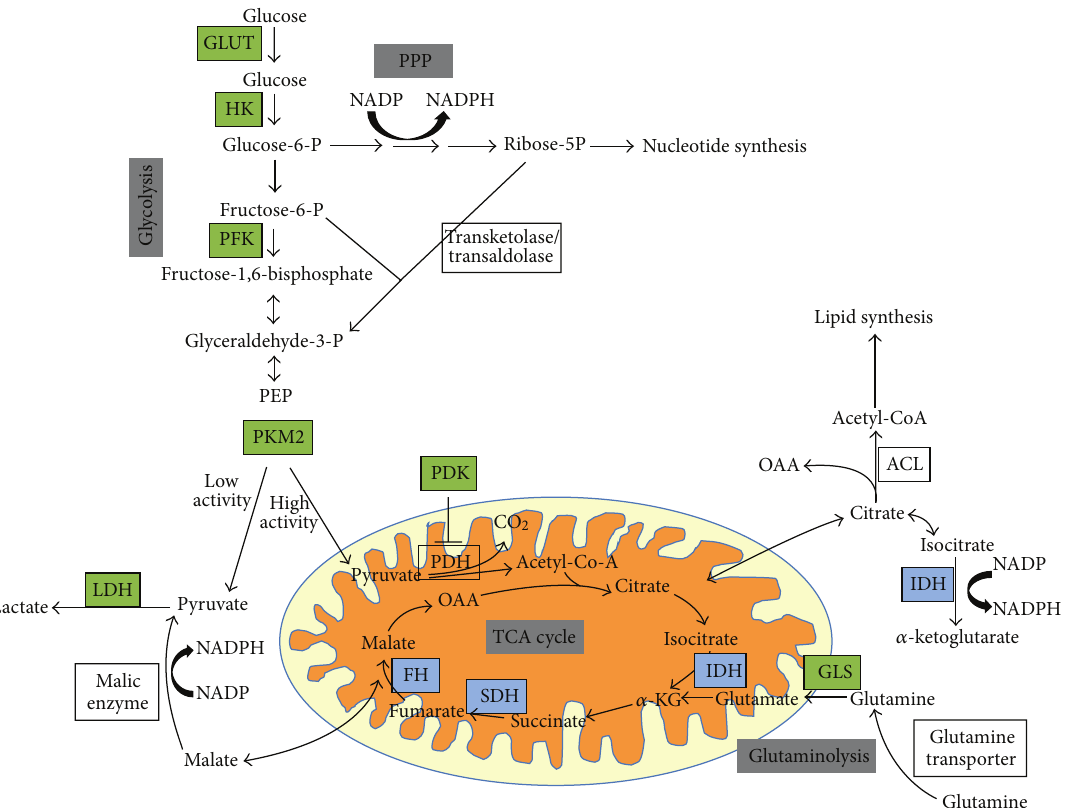
Figure 1: Metabolic adaptations of cancer cells. Glucose and glutamine are the 2 major substrates used by cancer cells. Glucose is imported into the cells through glucose transporters (GLUT) where it is phosphorylated by Hexokinase (HK). It will then be either metabolized through glycolysis or diverted to the pentose phosphate pathway (PPP). Glucose-derived pyruvate is mainly converted into lactate in cancer cells instead of being imported into mitochondria to be oxidized in acetyl CoA to support mitochondrial energy production. MYC enables cancer cells to maximize glutamine uptake from the extracellular space through the upregulation of the glutamine transporter. Once glutamine enters the cell, it can be metabolized through glutaminolysis to provide glutamate. The transamination of glutamate to 𝛼 KG will feed the TCA cycle (adapted from Vander-Heiden et al. [9]). 𝛼 KG: 𝛼 -KetoGlutarate; TCA: tricarboxylic acid cycle; PDH: pyruvate dehydrogenase; LDH: lactate dehydrogenase; PDK: PDH-kinase; PK: pyruvate kinase; PEP: phosphoenolpyruvate; GLS: glutamine synthase; SDH: succinate dehydrogenase; FH: fumarate hydratase; 2-HG: 2D-hydroxyGlutarate; IDH: isocitrate dehydrogenase; HK: hexokinase; GAPDH: glyceraldehyde 3-phosphate